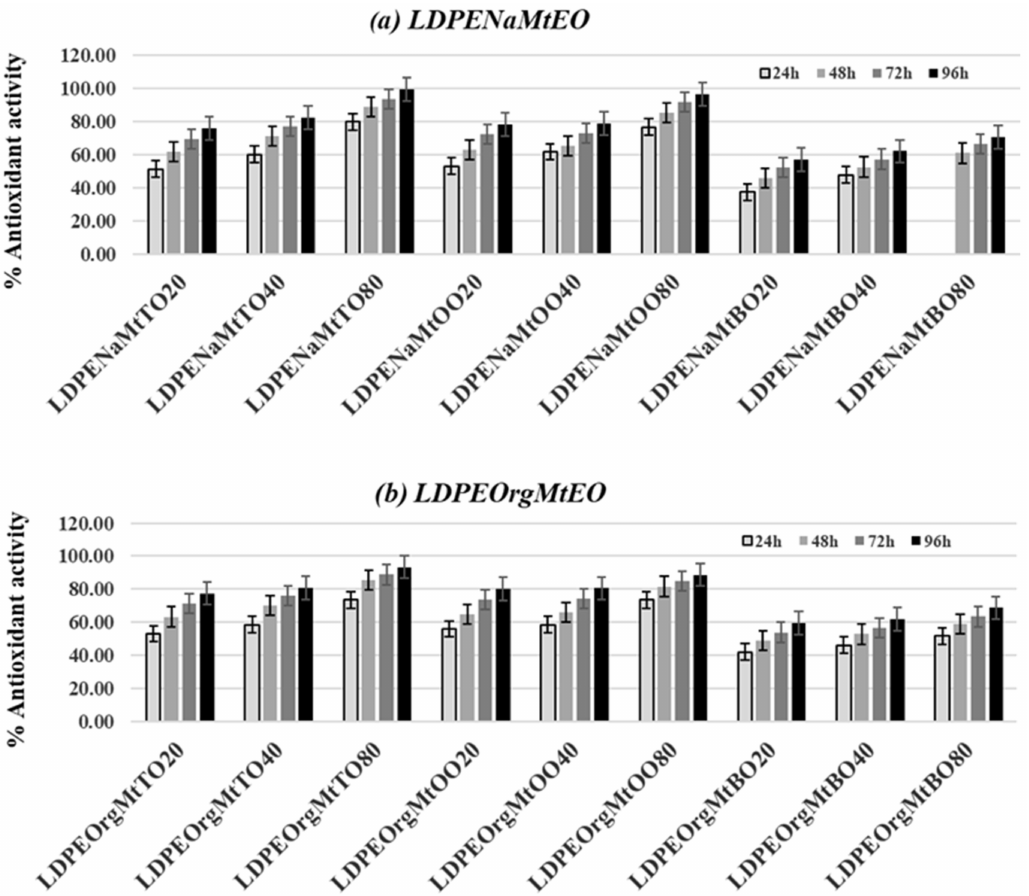
Figure 5. ( a ) column bar diagram of % antioxidant activity values of all tested LDPENaMtEO films after 24, 48, 72, and 96 h and ( b ) column bar diagram of % antioxidant activity values of all tested LDPEOrgMtEO films after 24, 48, 72, and 96